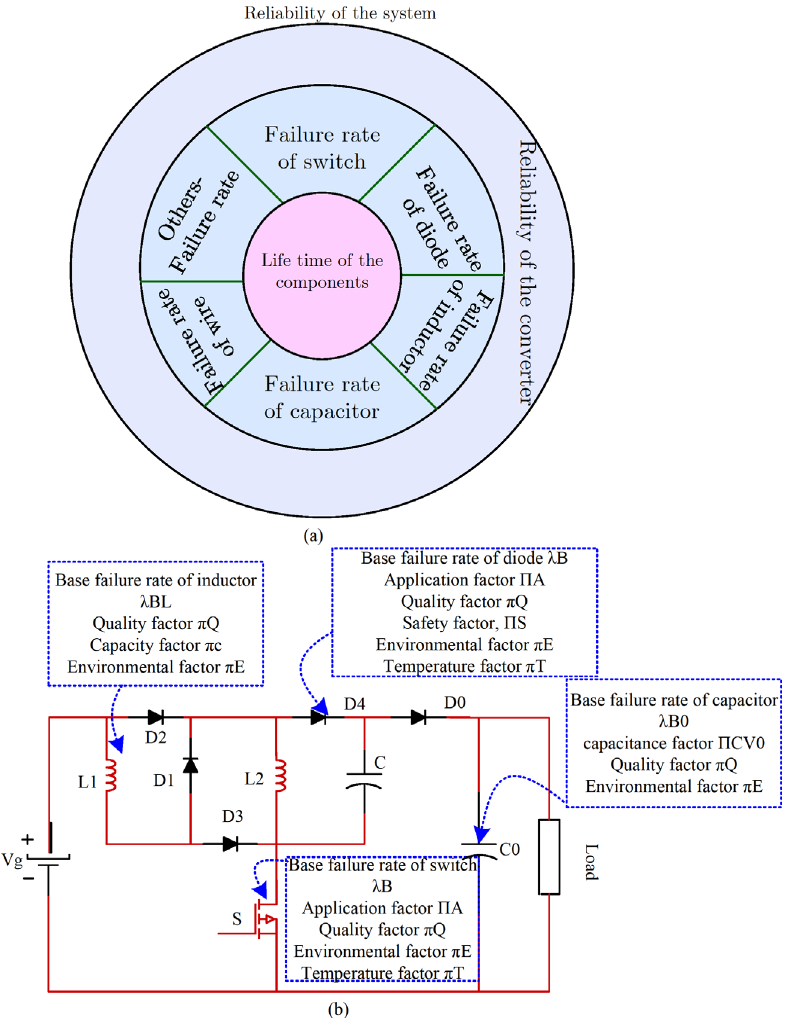
Figure 10. ( a ) Factors affecting the lifetime of the system and ( b ) Parameters influencing converter component’s reliability.